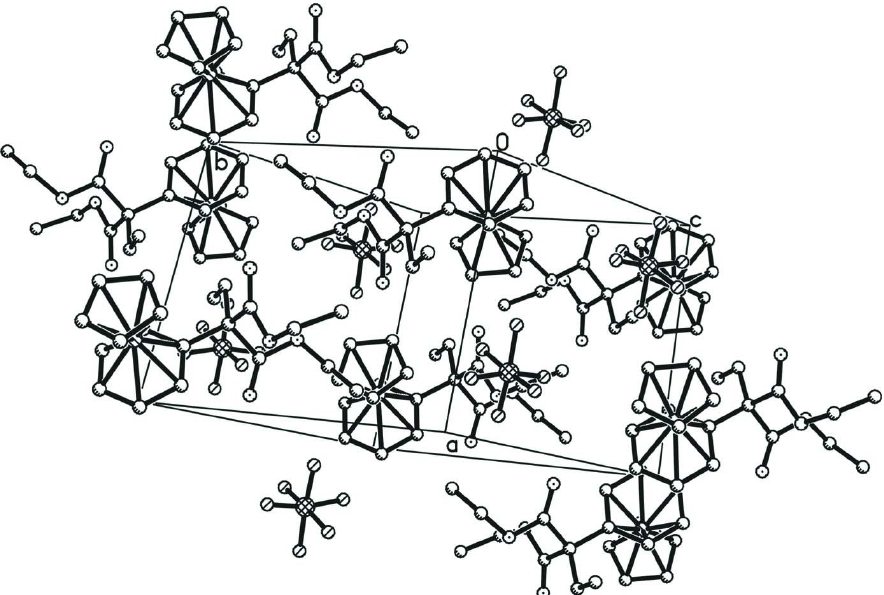
Figure 2 The packing diagram for the